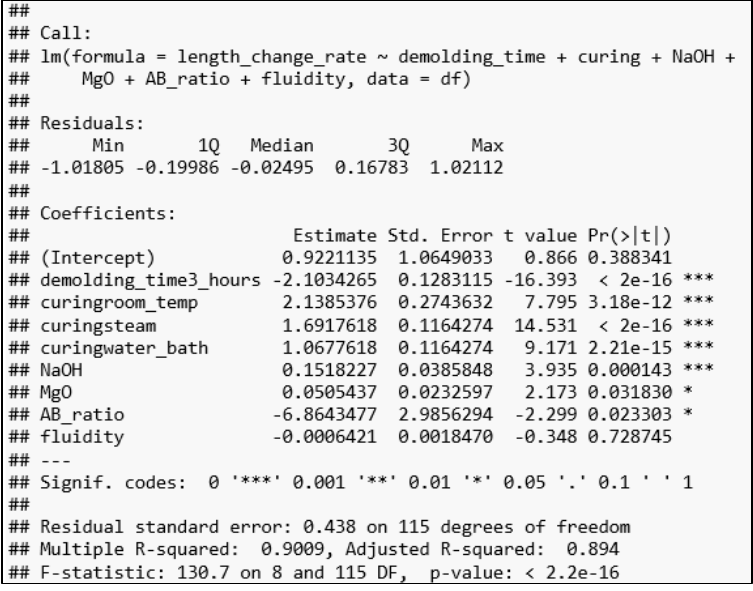
Figure 11. The multiple regression analysis for the length change ratio basing on 124 specimens’ data.